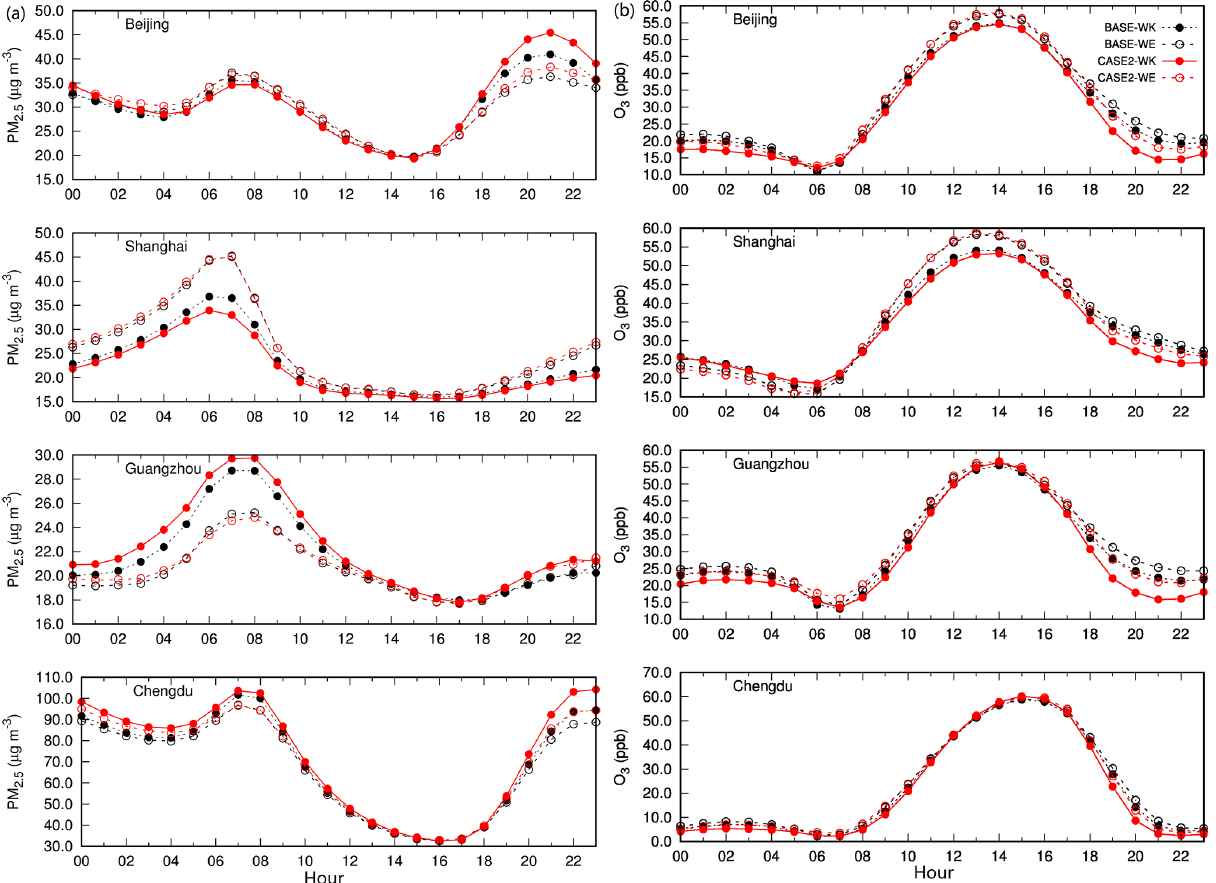
Figure 3. The diurnal profile of PM 2 . 5 and O 3 concentrations of BASE (without considering congestion) and CASE 2 (considering conges- tion) in Beijing, Shanghai, Guangzhou and Chengdu. WK: workday; WE: weekend.